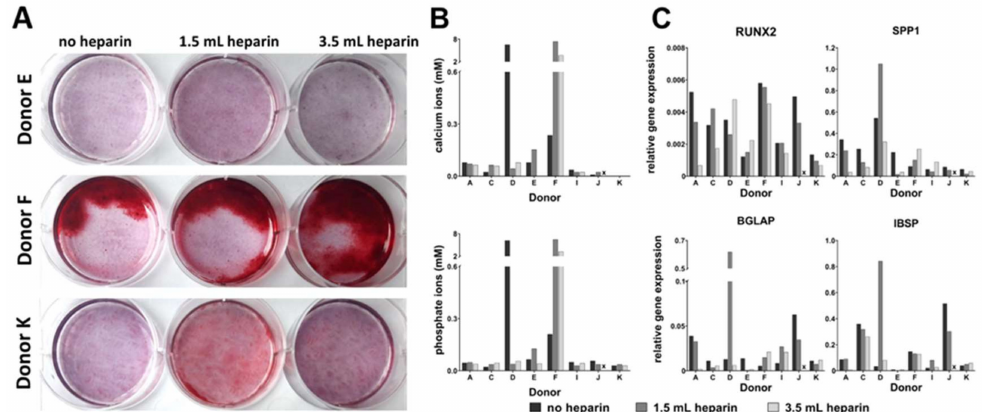
Figure 6. Osteogenesis in vitro. ( A ) Alizarin Red S-staining for calcium ions of randomly chosen donors (E, F, K), macroscopic views. ( B ) Determination of calcium and phosphate ion content in the cell layers as arithmetic means of individual duplicate samples. ( C ) quantitative realtime PCR (qRT-PCR) analysis for osteogenic marker genes (2 − ∆ Ct) at day 27. x: available cell numbers were too low